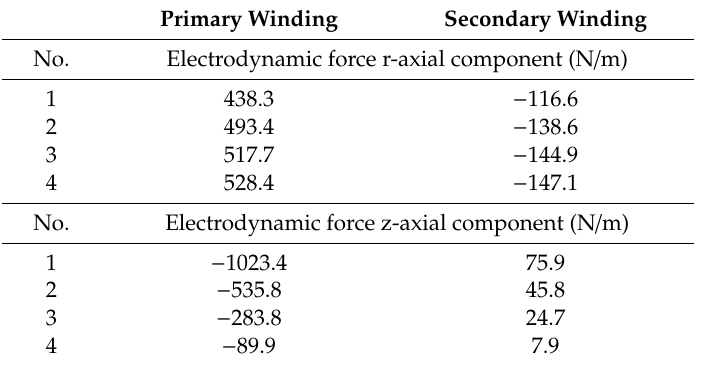
Figure 9. Electrodynamic force distribution at the first current peak of primary winding under voltage magnitude of 30 V: ( a ) R-axial component, ( b ) z-axial component, ( c ) electrodynamic force direction. To ensure that the SFCL will not be destroyed in the structure under short-circuit current, the electrodynamic force a ff ecting di ff erent parts of the winding should be considered in the design. The superconducting coils in the primary and secondary windings of the upper half of the SFCL are numbered and calculated by the electrodynamic force they a ff ect; the numbers are shown in Figure 9c and the calculation results are shown in Table 2. Table 2. Stress of pancake winding under first peak current of primary winding.